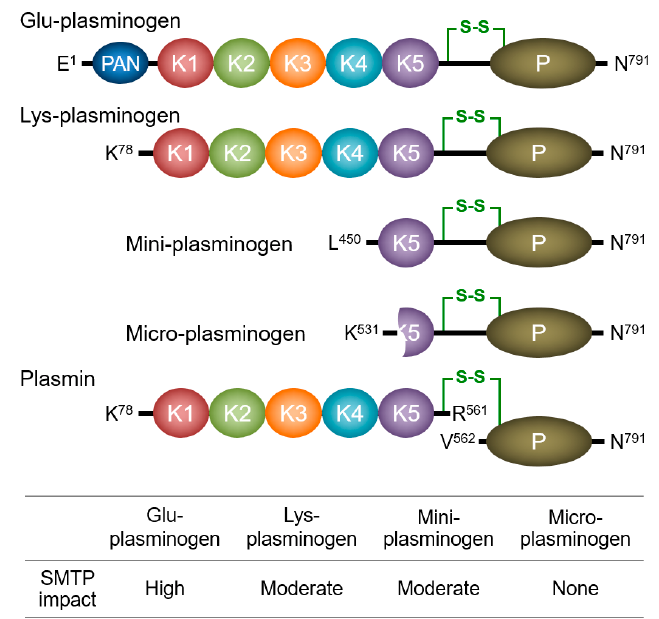
Figure 3. Plasminogen species. Schematic structures of the four plasminogen species and plasmin, and the effect of SMTP ‐ 7 on the activation of the four plasminogen species [97] are presented. A key disulfide bond connects the two chains of plasmin (green line). PAN, plasminogen–apple–nematode domain; K, kringle domain; P, protease domain.